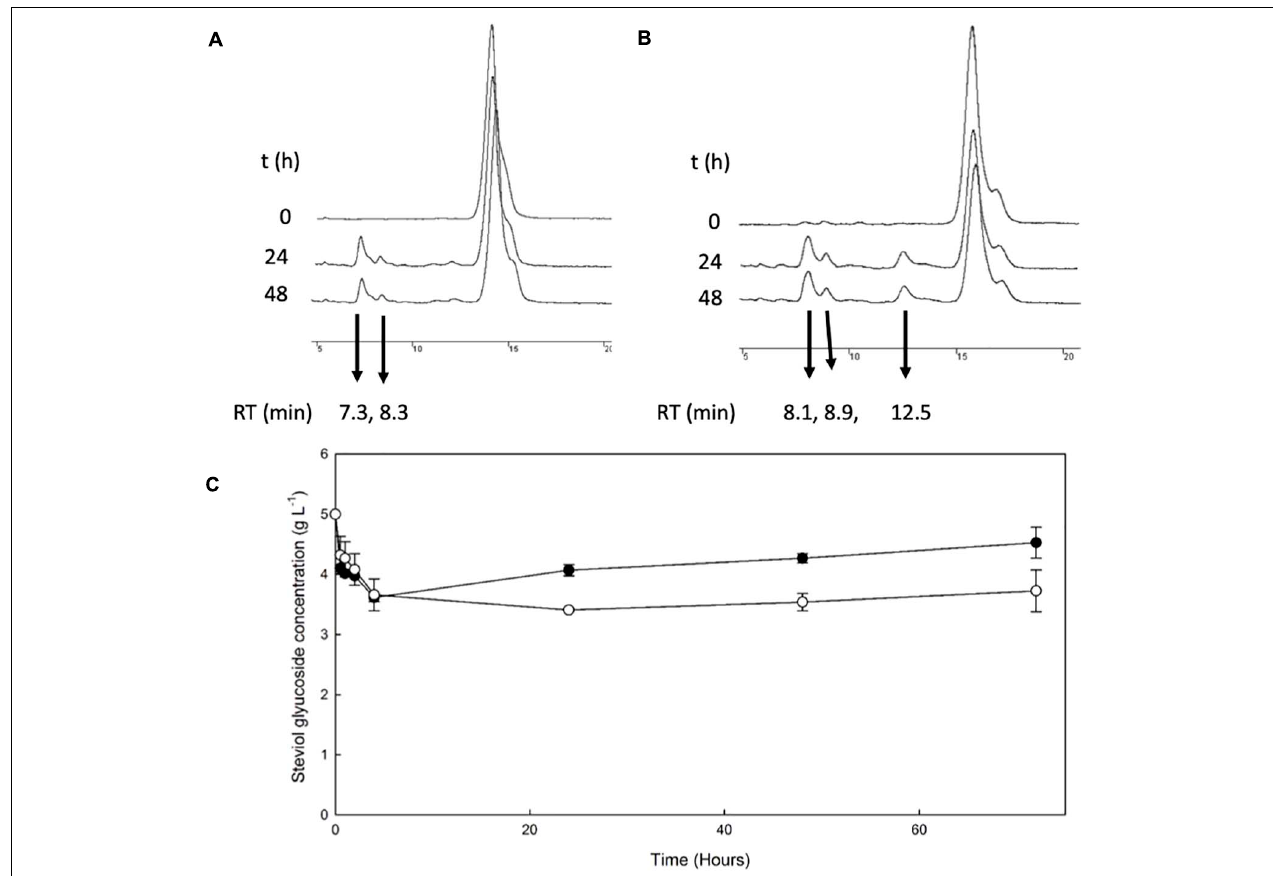
FIGURE 1 | Transglycosylation of steviol glycosides by Tt bGal1. HPLC chromatograms of the reaction mixture of Tt bGal1 with stevioside (A) and RebA (B) , with lactose as the donor (C) Tt bGal1-mediated bioconversion of stevioside ( black squares ) and RebA ( white circles ).